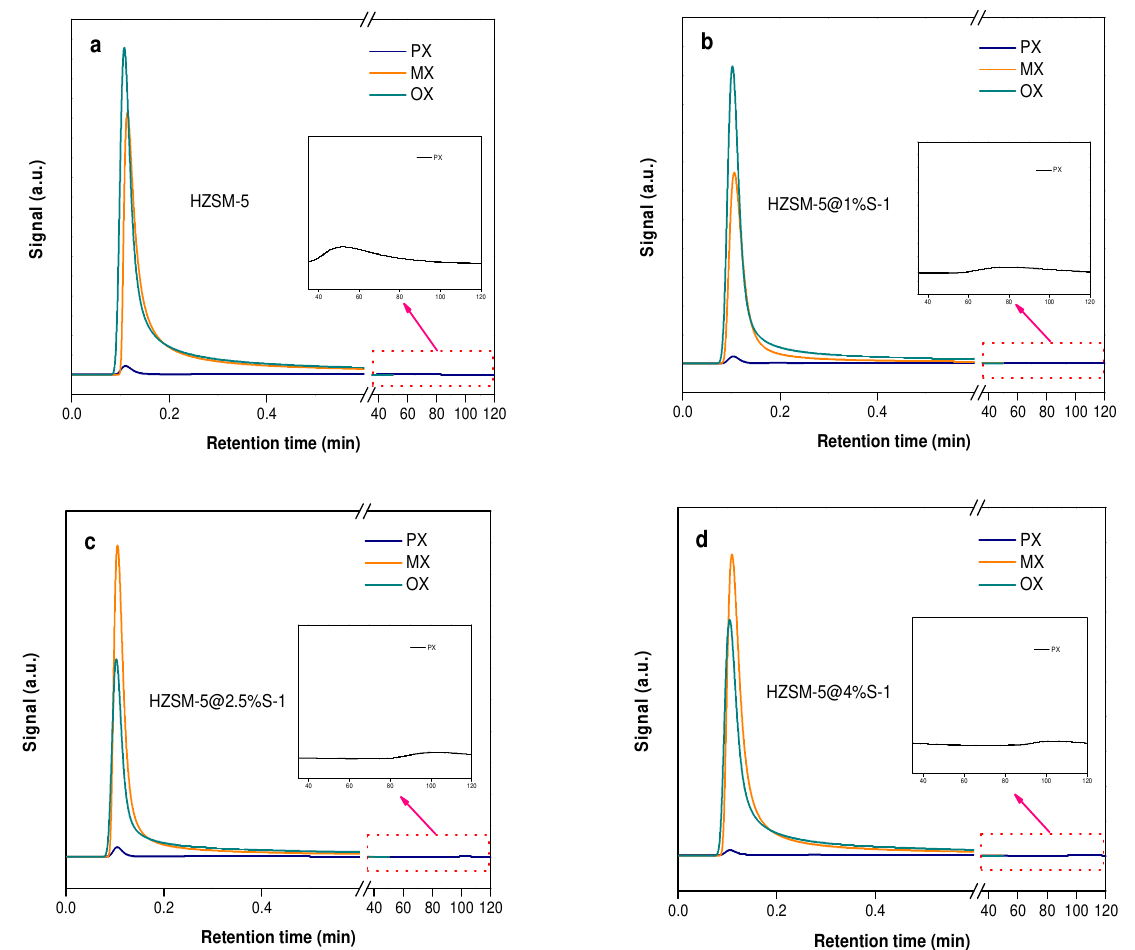
Figure 6. Pulse chromatography signal of xylene isomers (OX: o -xylene; MX: m -xylene; PX: p -xylene) passing through columns packed with as prepared ( a ) HZSM-5, ( b ) HZSM-5@1%S-1, ( c ) HZSM- 5@2.5%S-1, and ( d ) HZSM-5@4%S-1 samples. The black solid lines illustrate a partial enlargement of the PX signal.